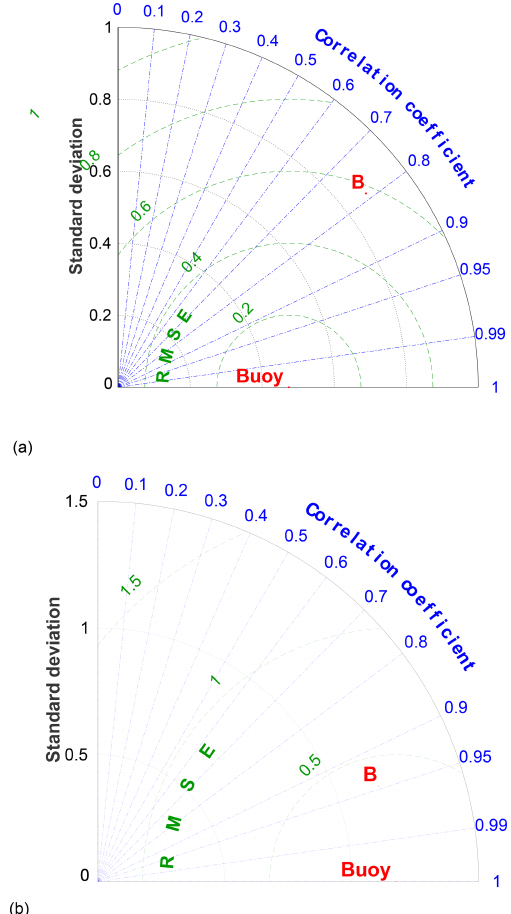
Figure 4. Taylor diagram for the significant wave height ( H s ) showing correlation, standard deviation and root mean square er- ror (RMSE) between numerical and observed data for (a) south sec- tor (Tarragona location) and (b) north sector (Begur location). The time period ranges from November 2016 to March 2017.